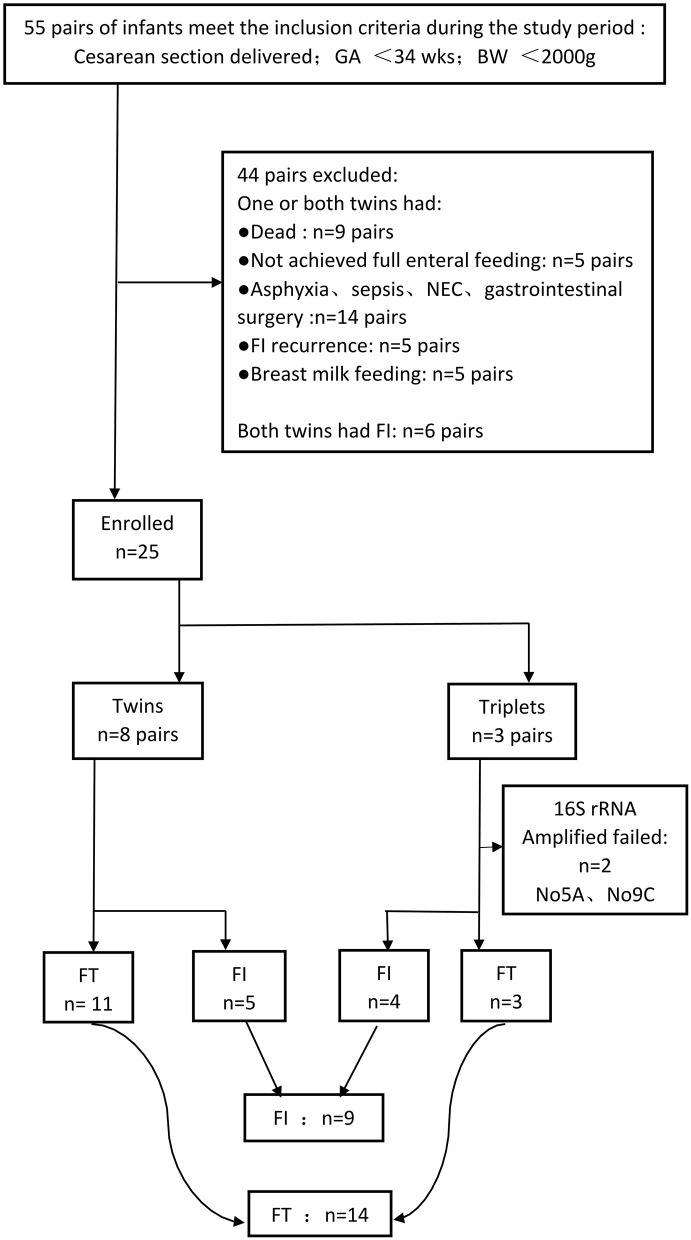
Flowchart of our search.